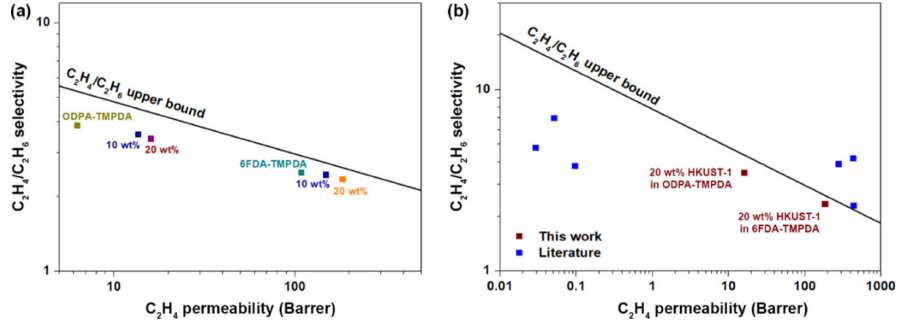
Figure 7. ( a ) Comparison of the synthesized membranes (pure polymer and mixed-matrix) with reference to the C 2 H 4 / C 2 H 6 upper bound. The upper bound is constructed based on ref. [24]. ( b ) Mixture–gas performance comparison of our mixed-matrix membranes with literature data [52,60]. Table 3. Summary of C 2 H 4 / C 2 H 6 pure component gas permeation results of the mixed-matrix membranes that are available in the literature.